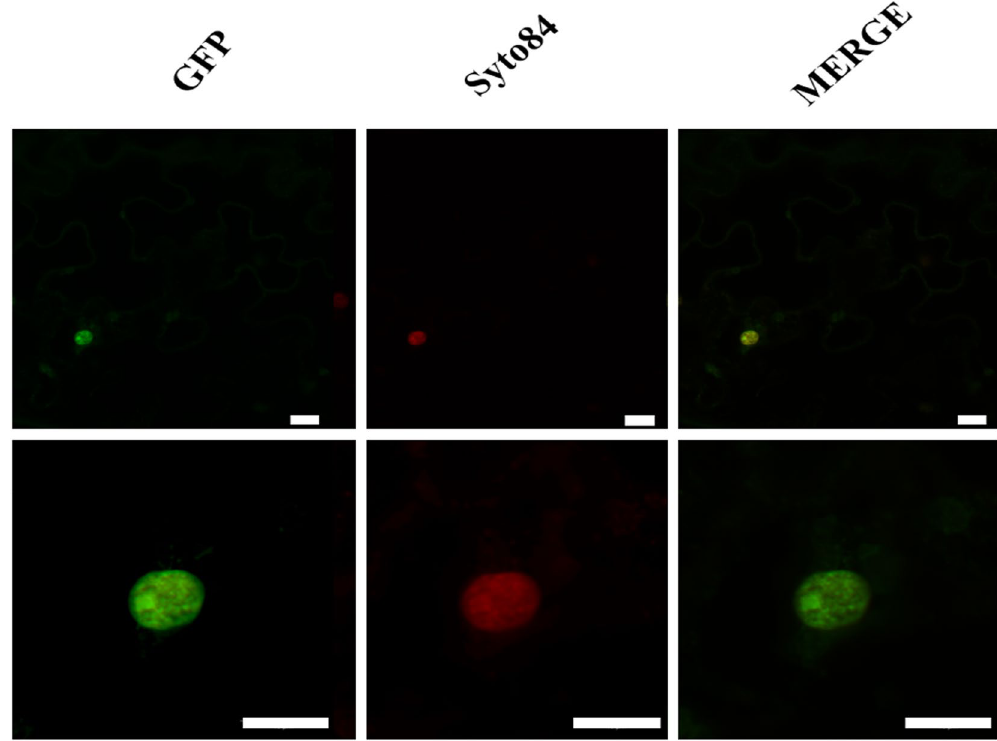
Figure 3. FcNAC1 subcellular localization of the transcription factor by transient transformation of tobacco leaves. Co-localization assay of FcNAC1 protein fused to GFP in vector pK7WGF2.0. Agrobacterium tumefaciens LV300 strains were used to transiently transform young leaves from tobacco plants (6-week-old). Syto84 staining was used to locate the nucleus. GFP: Green Fluorescent Protein, Syto84: nuclear staining, MERGE: superposition of GFP and Syto84 images. The white bar indicates 10 µ m.